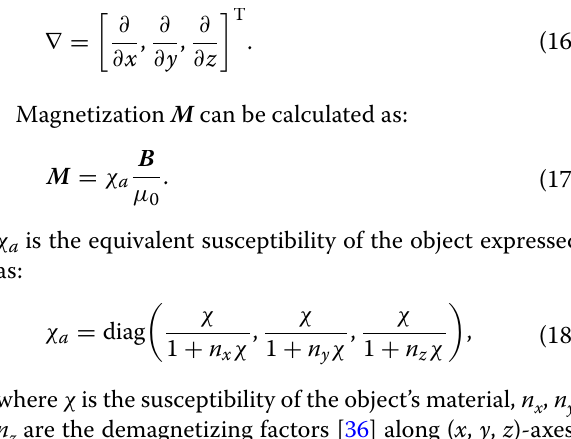
Figure 3 Impact of pose of the axially symmetric